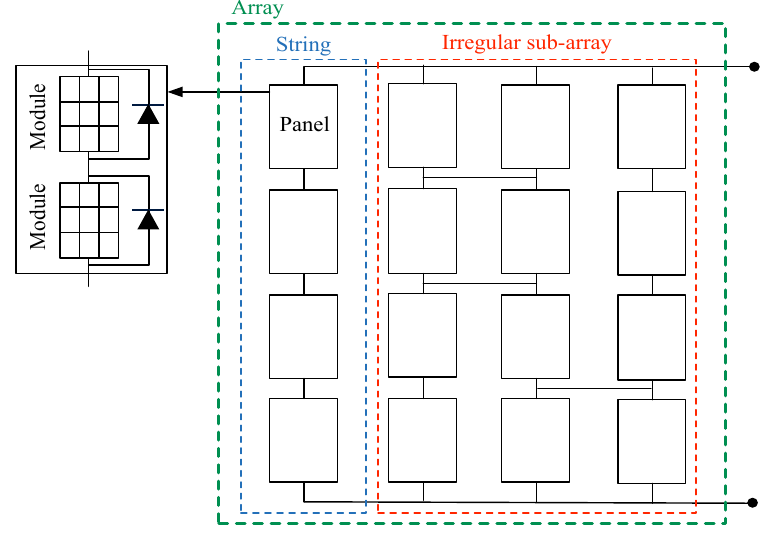
Figure 1. An irregular PV array formed by panels of two modules